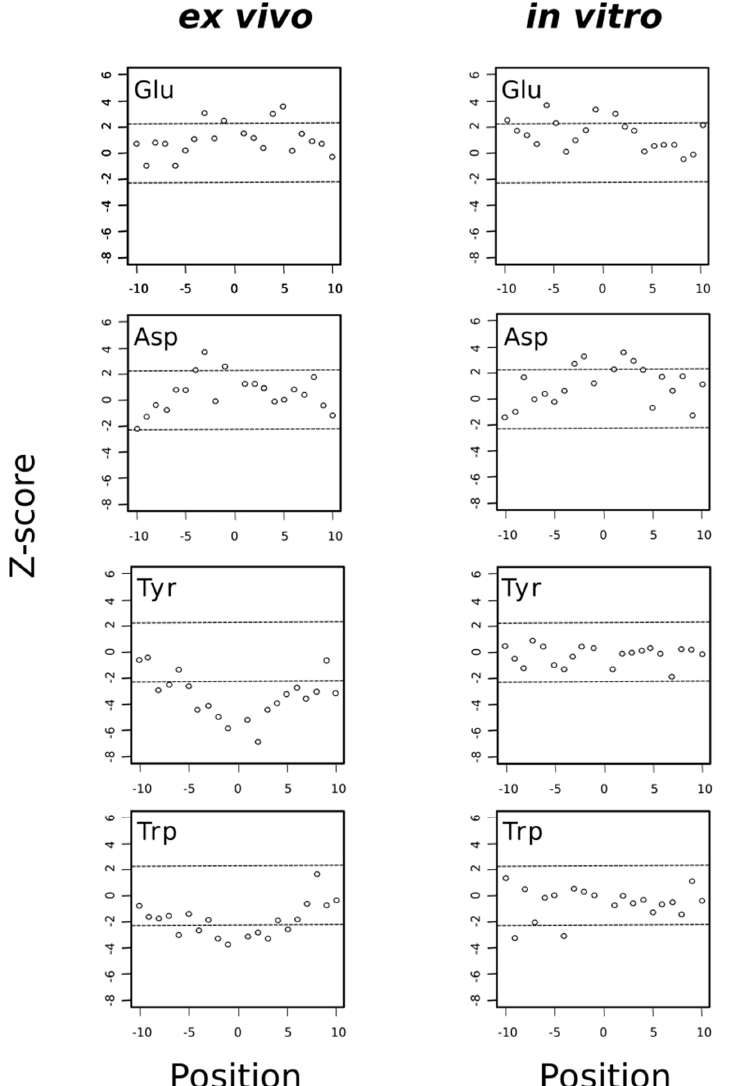
Figure 10. Acidic residues are overrepresented around MetO sites regardless the conditions while aromatic residues are underrepresented only around ex vivo MetO sites. A Z-score that is much greater than zero indicates that the analyzed amino acid is overrepresented at the indicated position. Conversely, a Z-score that is much less than zero indicates that the amino acid being analyzed is underrepresented at that position. The horizontal dashed lines delimit the 99.5% confidence interval of the Z-statistic. On the other hand, the aromatic residues tryptophan and particularly tyrosine were clearly avoided in the proximity of MetO originated ex vivo but not in the vicinity of those MetO formed in